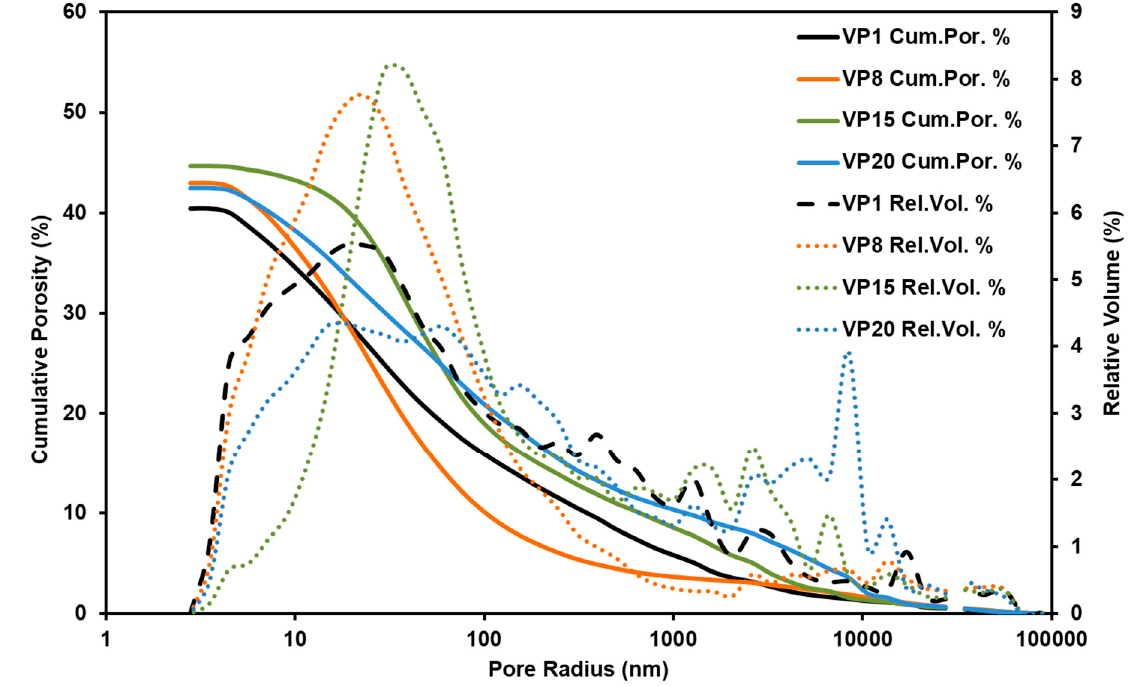
Figure 10. Cumulative (continuous line) and relative (dashed line) pore size distribution of Villa del Pezzolo mortars (VP1, VP8, VP15, VP20).